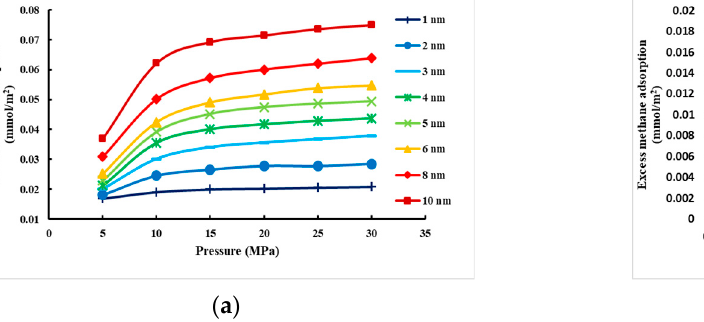
Figure 3. Methane adsorption capacity at different pore sizes ( a ): Total methane adsorption capacity, ( b ): Excess methane adsorption capacity.